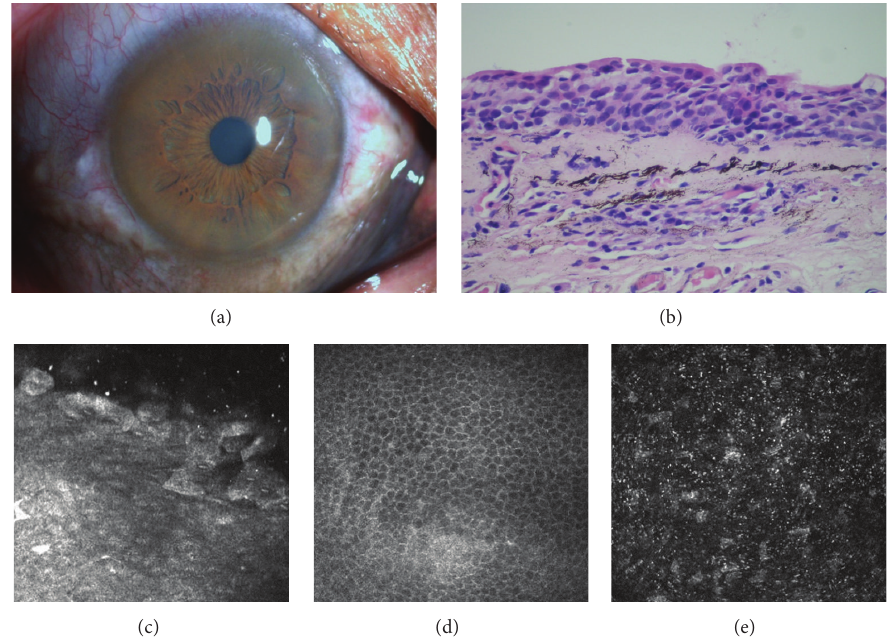
Figure 1: (a) Diffuse black-gray pigmentation in ocular surface in both eyes. (b) Histopathology revealed subepithelial extracellular silver particles in the substantia propria. (c) Squamous metaplastic changes on conjunctival epithelium and diffuse highly reflective extracellular punctiform deposits in conjunctival substantia propria. (d) Normal corneal epithelium on confocal microscopy. (e) Highly reflective punctiform deposits in the stroma demonstrated with confocal